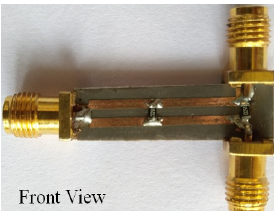
FIGURE 3. Fabricated prototype